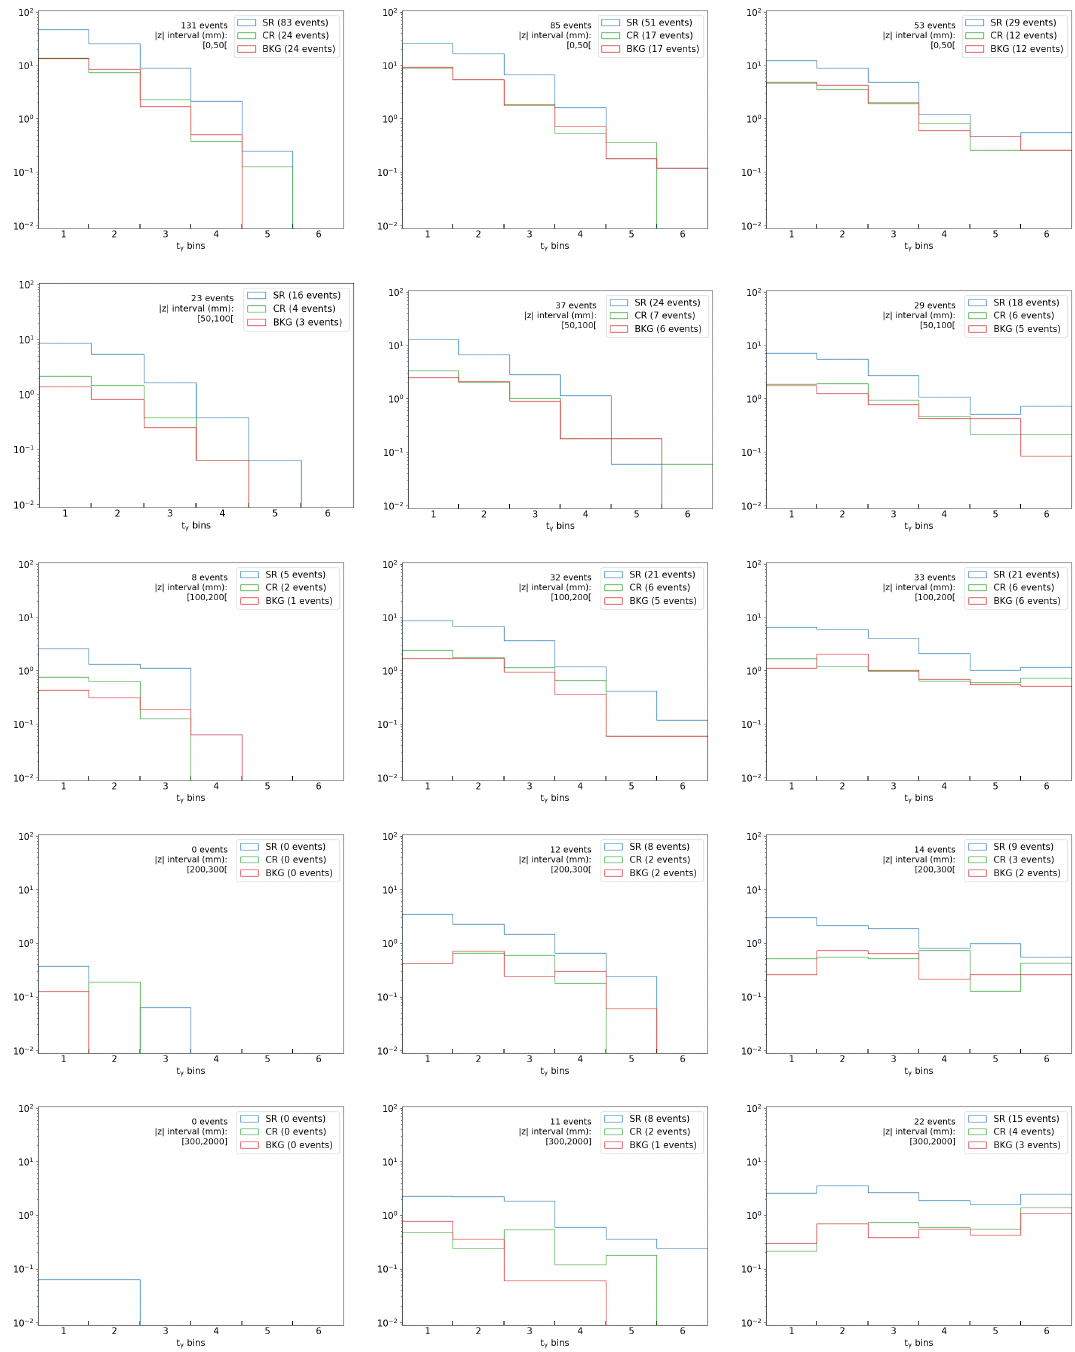
Figure 9 . Event distribution for the multi-photon category, for M h = 10 , 30 , 50 GeV on the left, center and right columns, respectively. Each row indicates a different | ∆ z γ | range. The six bins indicate t γ values between 0, 0.2, 0.4, 0.6, 0.8, 1 and 12 ns. Events in different regions are not